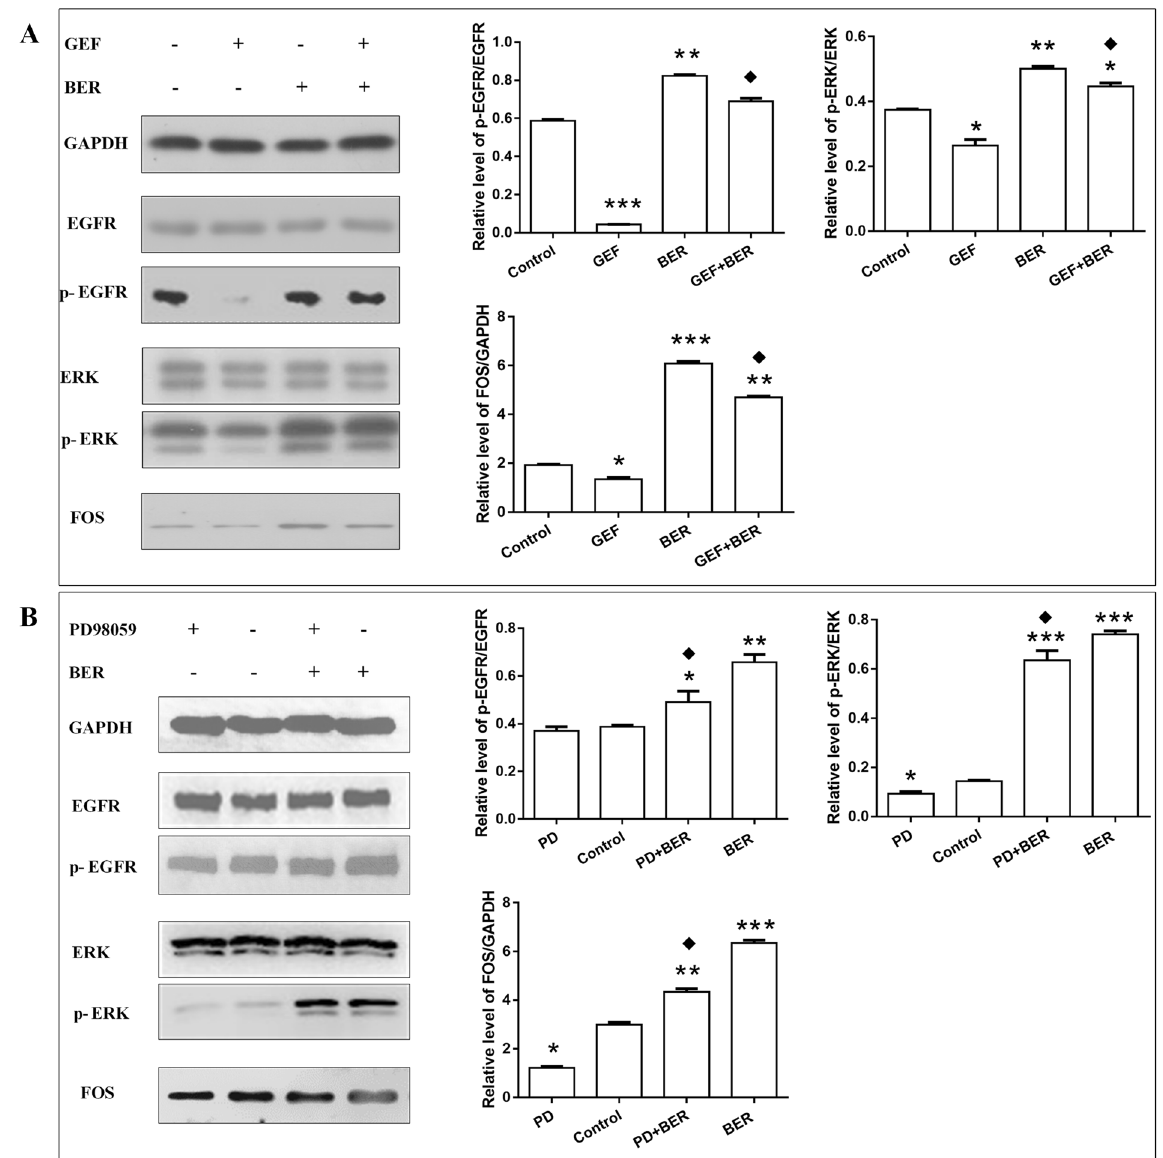
Figure 5. The effects of affinity between BER and hPDLSC through EGFR-ERK-FOS. ( A ) The expression of EGFR, p-EGFR, ERK, p-ERK and FOS in four groups (from left to right: control; 2 μ g/L GEF 24 h; 0.1 mg/L BER 15 min; pretreatment with 2 μ g/L GEF 24 h, then intervened with 0.1 mg/L BER for 15 min) were examined using western blot. ( B ) The expression of EGFR, p-EGFR, ERK, p-ERK and FOS in four groups (from left to right: 50 μ mol/L PD98059, 30 min; control; pretreatment with 50 μ mol/L PD98059, 30 min, then intervened with 0.1 mg/L BER 15 min; 0.1 mg/L BER for 15 min) were examined using western blot. ( vs control, * P < 0.05; ** P < 0.01, *** P < 0.001; vs BER, ◆ P < 0.05) (GEF: Gefitinib, BER: